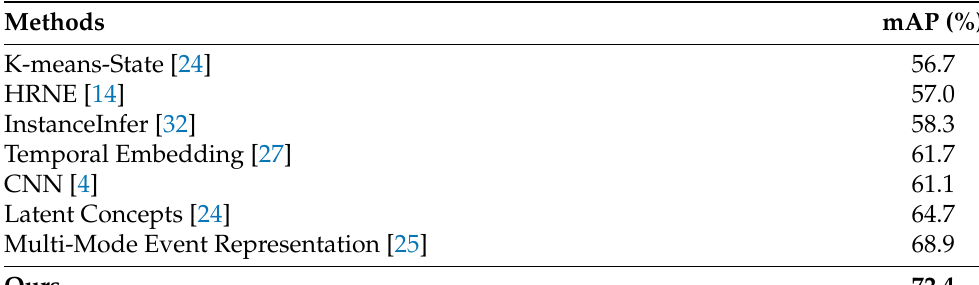
Table 4. Performance comparisons of the proposed method with other event detection methods on the CCV